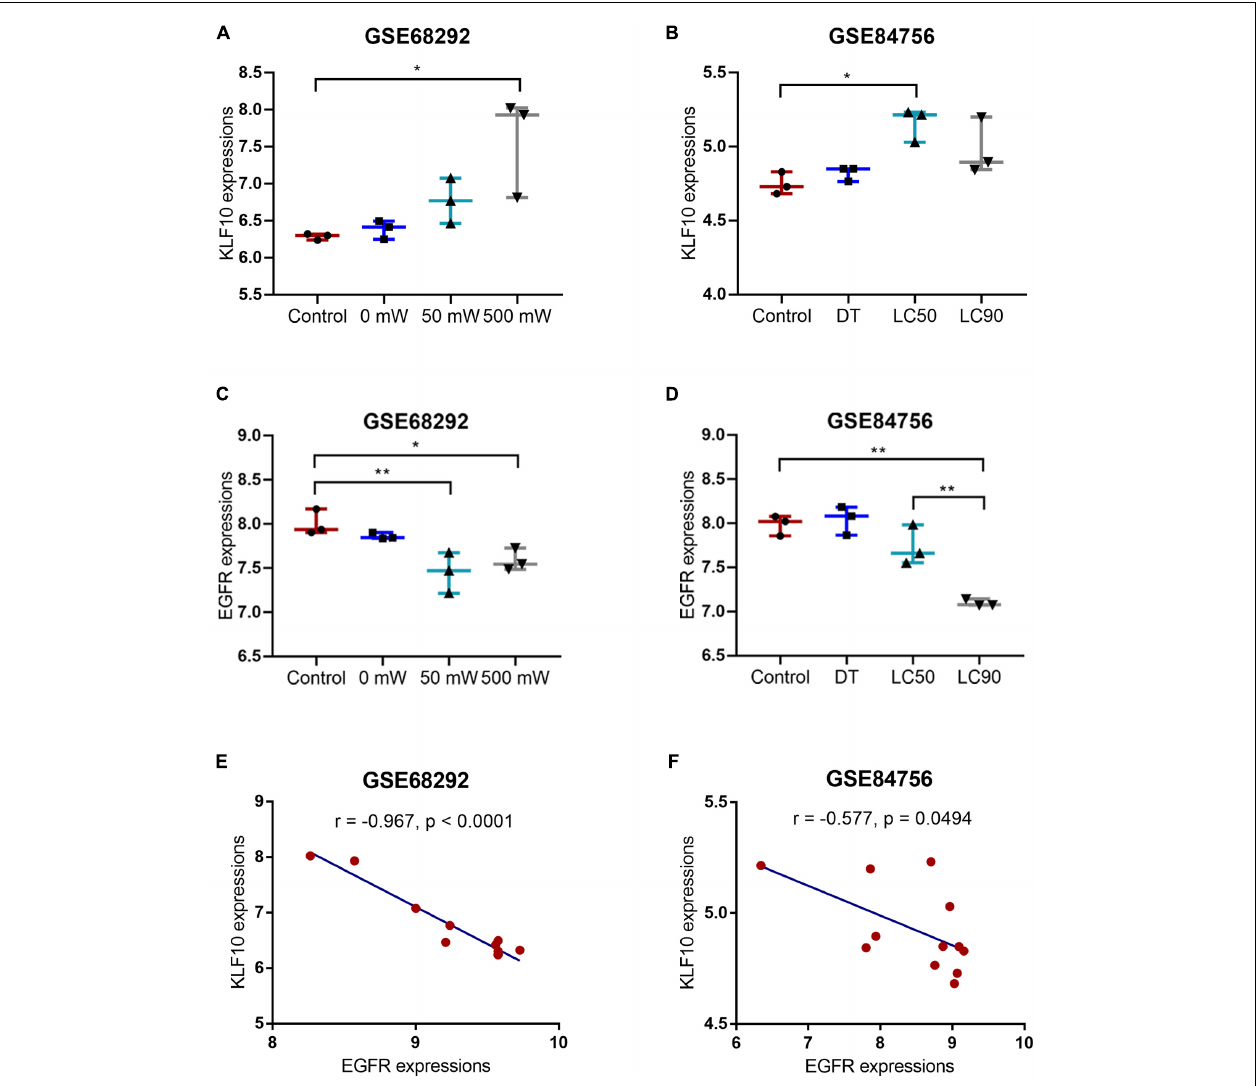
FIGURE 3 | KLF10 expression and correlation with EGFR. (A) KLF10 expression under the control, 0, 50, or 500 mW PDT exposure, according to GSE68292. (B) KLF10 expression under the control, dark toxicity (DT), LC50, or LC90 PDT exposure, according to GSE84756. (C) EGFR expression under the control, 0, 50, or 500 mW PDT exposure, according to GSE68292. (D) EGFR expression under the control, dark toxicity (DT), LC50, or LC90 PDT exposure, according to GSE84756. (E) The correlation between KLF10 and EGFR expression, according to GSE68292. (F) The correlation between KLF10 and EGFR expression, according to GSE84756. * P < 0.05, ** P <